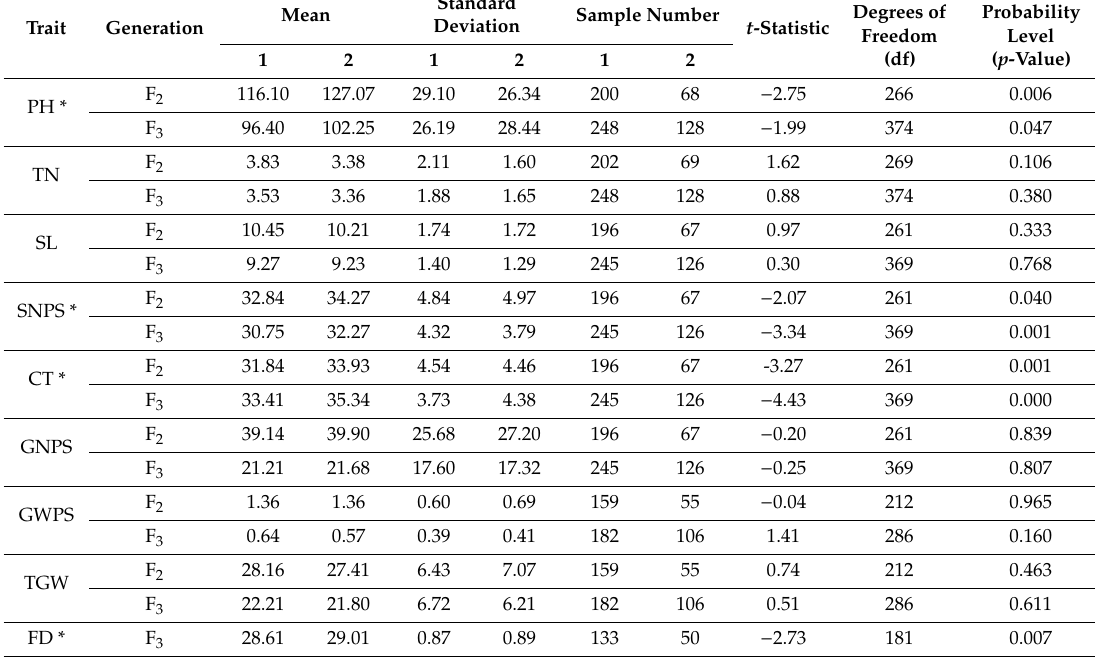
Table 1. The significance of di ff erences between the group of waxy ( 1 ) and waxless ( 2 ) plants of mapping population BK2, demonstrated using the t